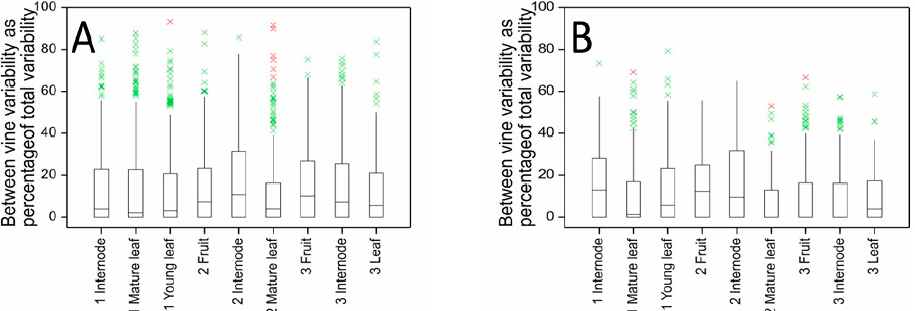
Figure 4. Between-vine (inter-vine) variability as a percentage of total variability for kiwifruit metabolites measured in fruit, internode and leaf tissues of ‘Hayward’ kiwifruit by LC-MS at three harvest times showing the distributions of percentage variance for ( A ) all metabolites and ( B ) for only those metabolites with CV <20%.